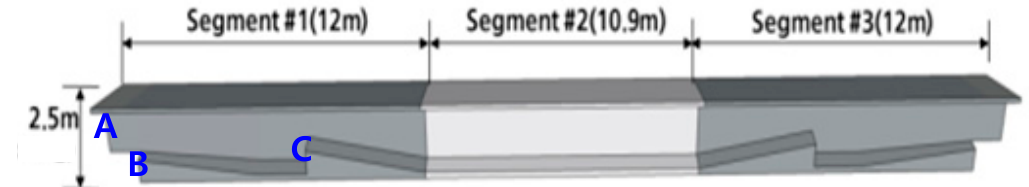
Figure 4. Shape and dimensions of full-scale bulb-T-shaped half-deck (BH) girder bridge prototype for the test.